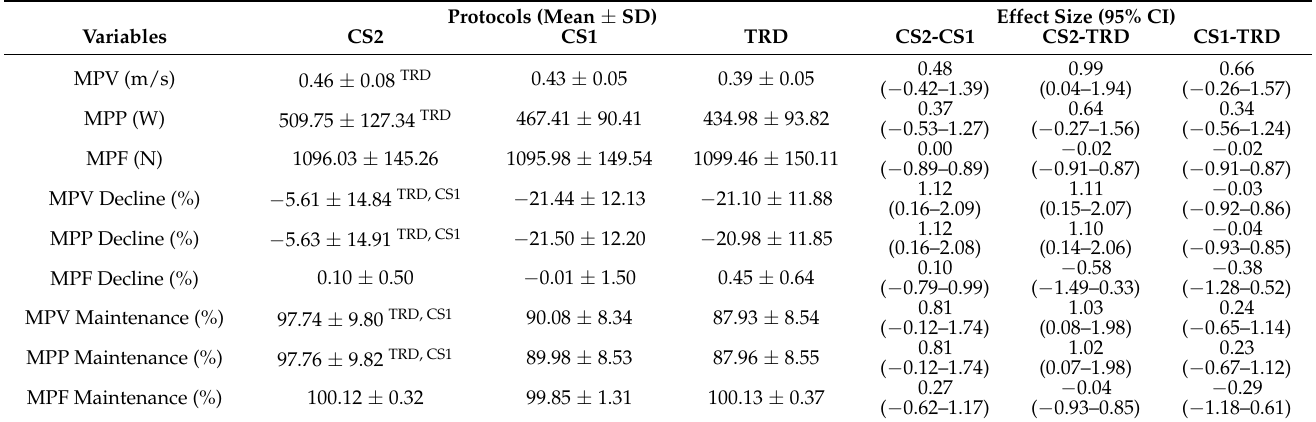
Table 1. Data (mean ± SD) comparison between protocols for all mechanical variables and their respective effect